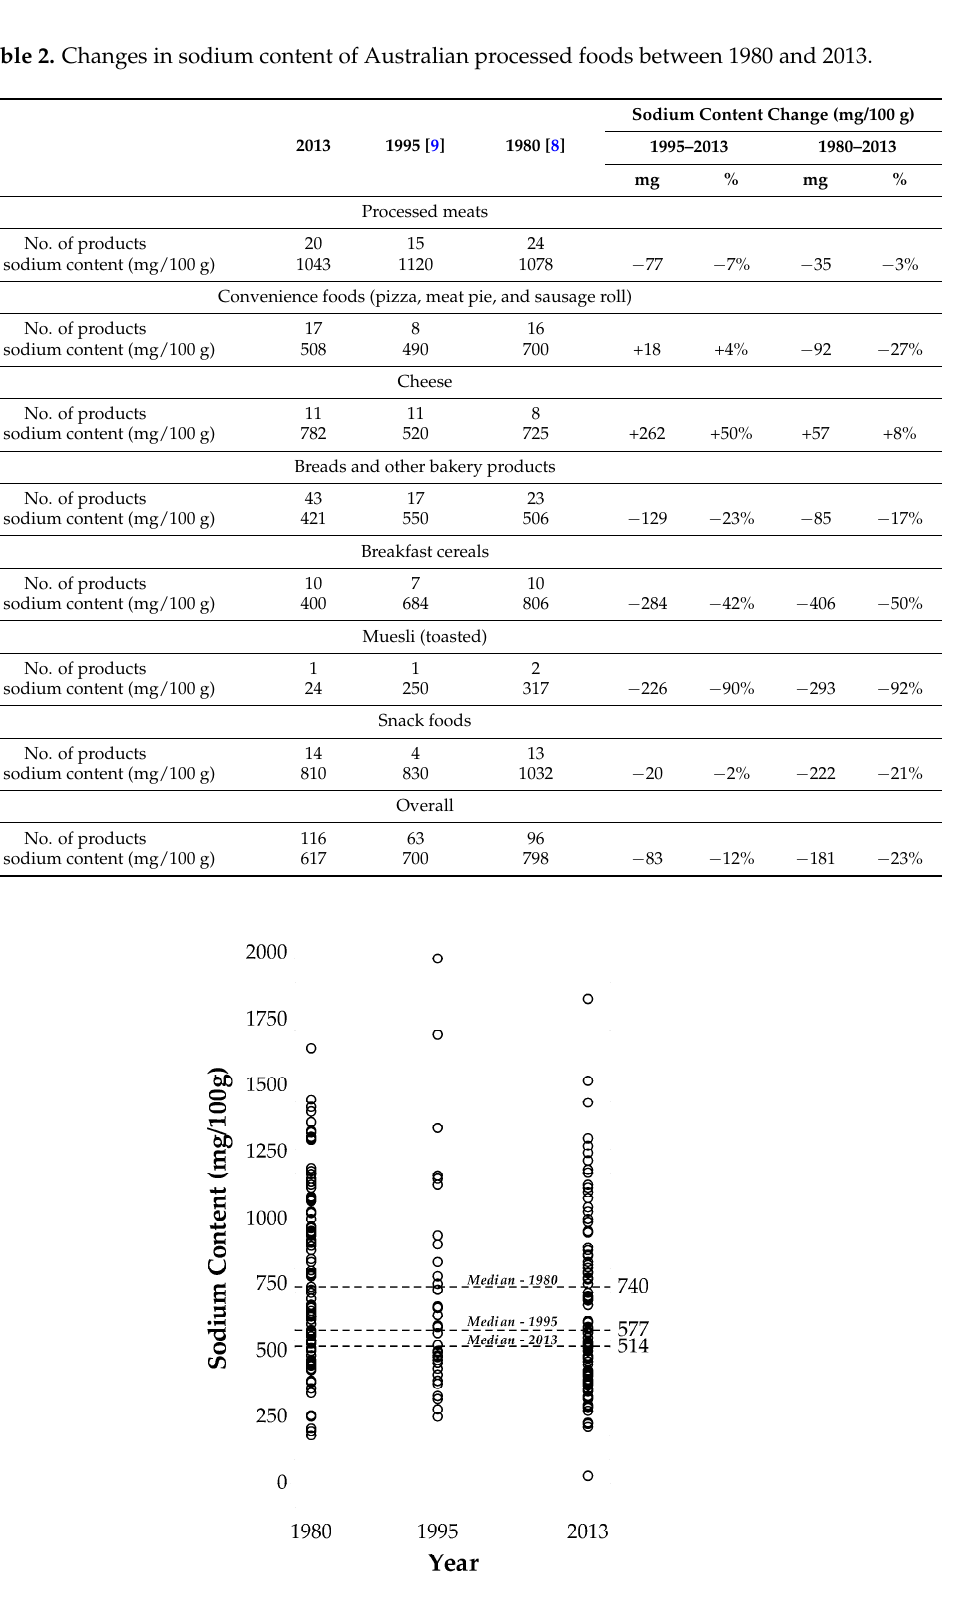
Figure 1. Comparison of the sodium contents of Australian processed foods between 1980 and 2013 where a circle represents each product.